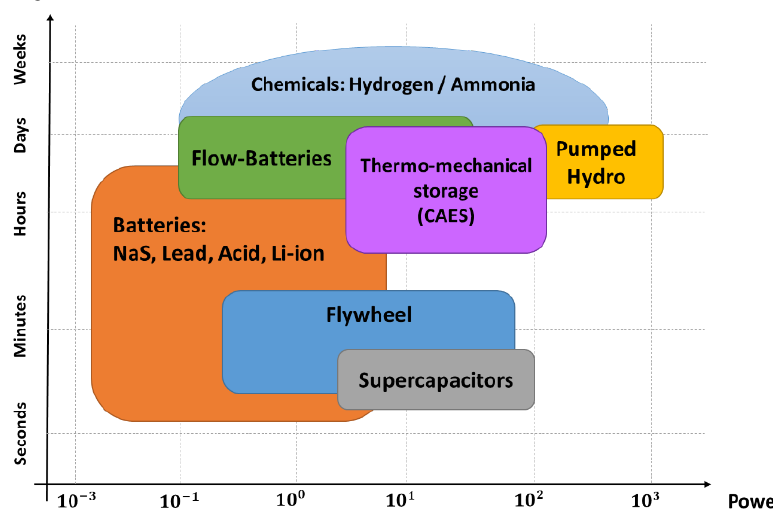
Table 2. Classification of the ESSs based on their cycle duration (based on [3,4]).